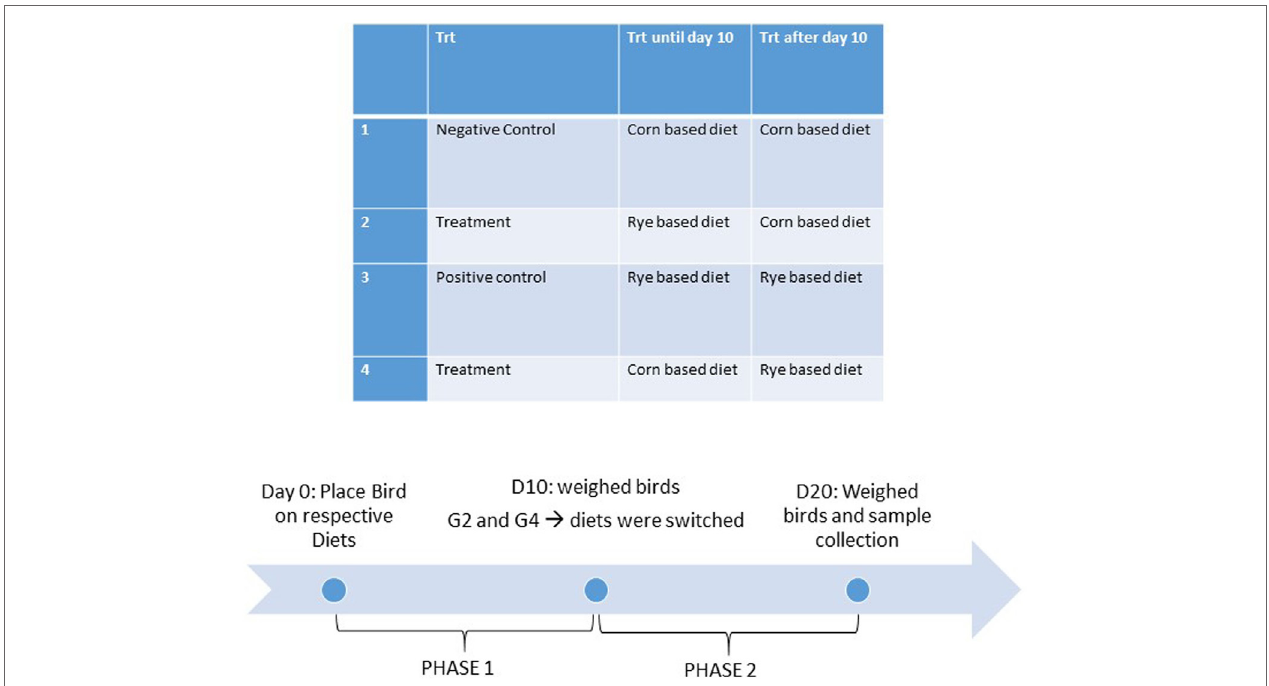
FigUre 1 | Dietary treatments and